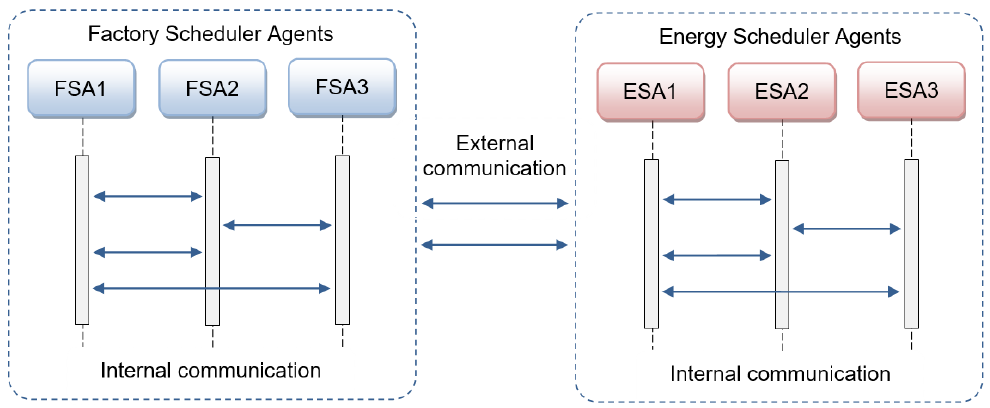
Figure 3. Agent-based control architecture of EasySched.